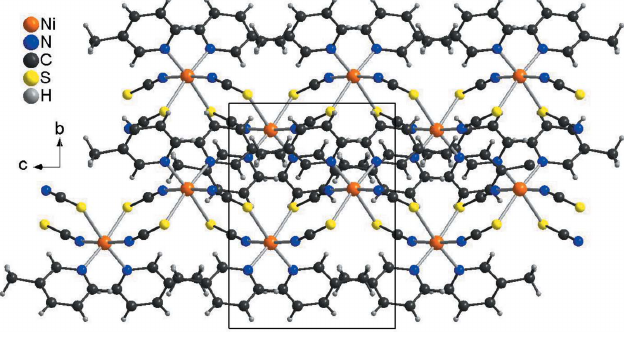
Figure 4 Crystal structure of the title compound with view along the crystal- lographic a -axis.